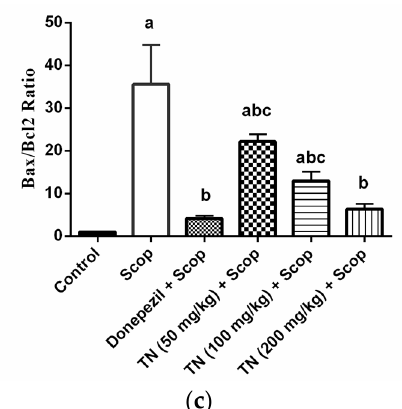
Figure 6. Effect of different doses of tiger nut on Scop-induced apoptosis. ( a ) Bax, ( b ) Bcl2 and ( c ) Bax/Bcl2 ratio. Values are expressed as the mean ± SD ( n = 6). Values are statistically significant at p < 0.05 versus the control group, p < 0.05 versus the Scop-treated group and p < 0.05 versus donepezil-treated group.